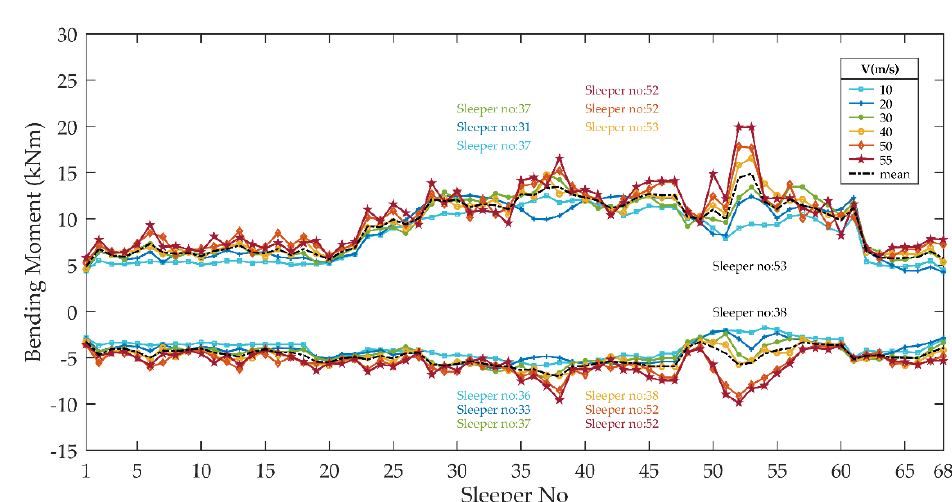
Figure 6. Longitudinal bending moment distribution with no track irregularities.